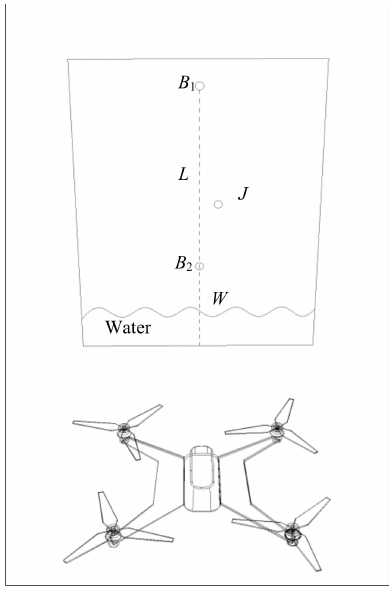
Figure 2. Schematic of image capture.